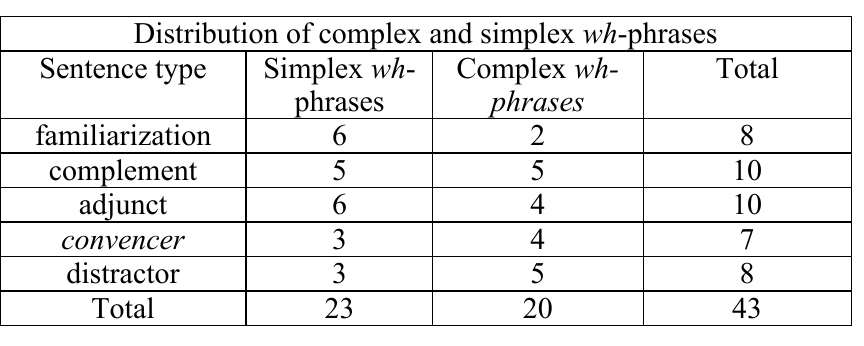
Table 1. Distribution of complex and simplex wh -phrases across sentence